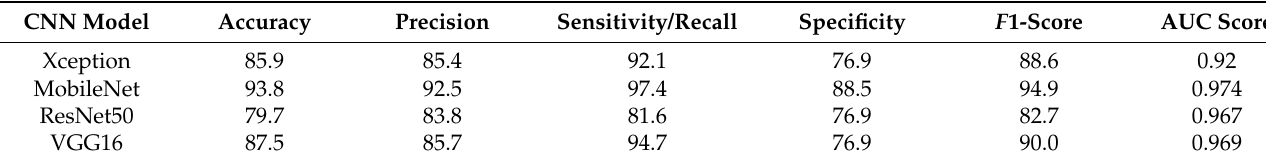
Table 4. Performance metrics juxtaposition.